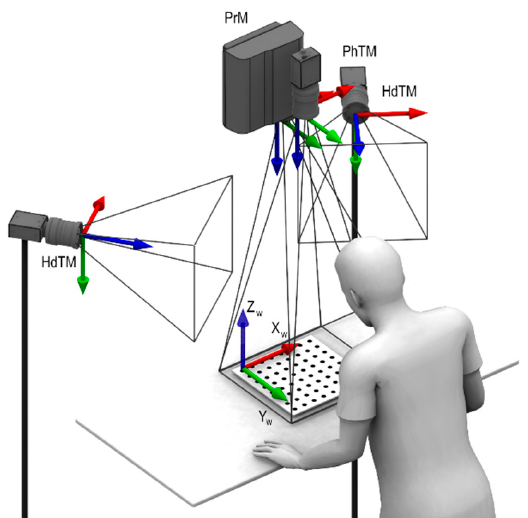
Figure 8. Local coordinate systems from the MARVIS devices. Red, green, and blue arrows correspond to the X , Y , and Z axes in the coordinate systems, respectively. X w , Y w , and Z w represent the axes of the global coordinate system.